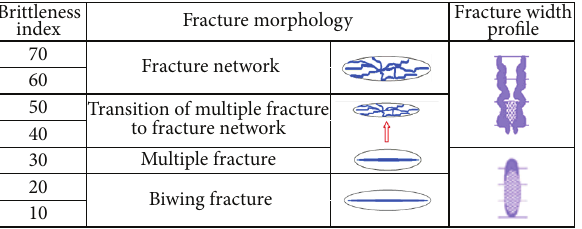
Figure 4: Effect of rock brittleness index on hydraulic fracture pattern